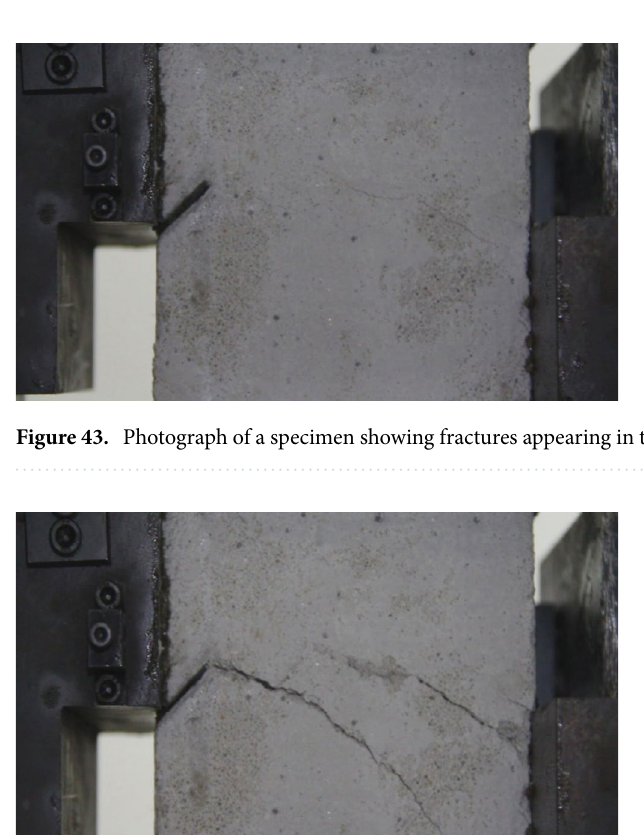
Figure 42. Photograph of a specimen showing fractures penetration.